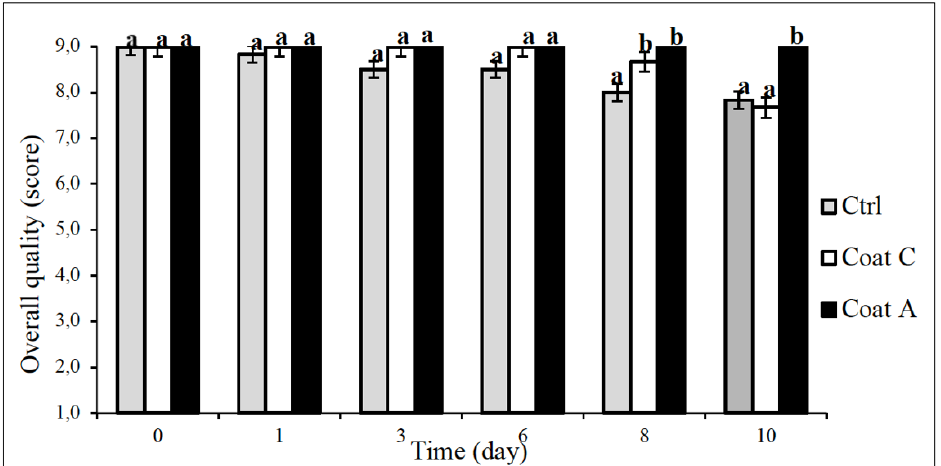
Figure 4. Sensory quality of control and coated prickly pears stored at 4 °C. Mean values ± standard deviation; Different letters indicate sample significantly different ( p < 0.05). Ctrl = sample without coating; Coat C = sample with alginate coating; Coat A = sample with alginate and peels.